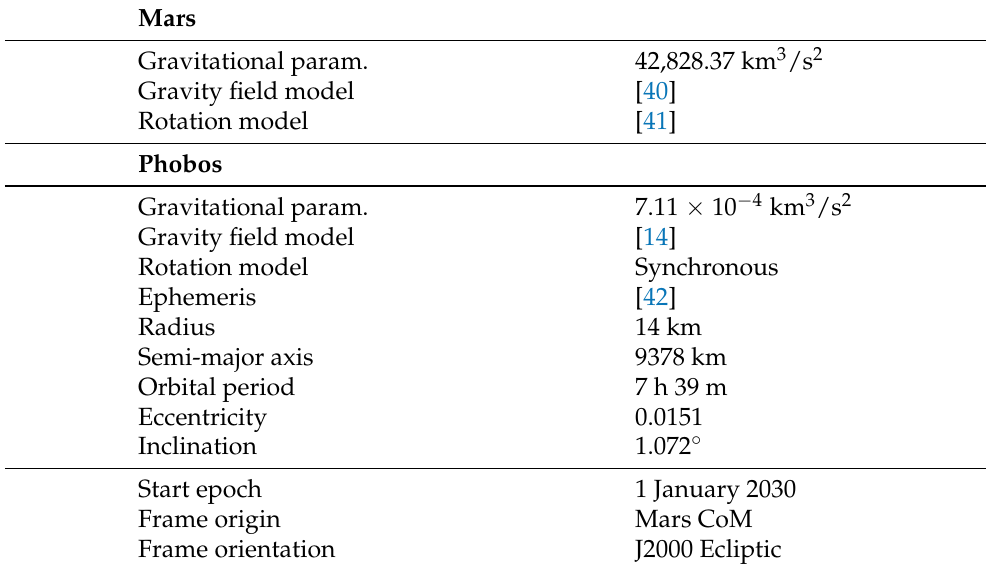
Table 2. Adopted dynamical